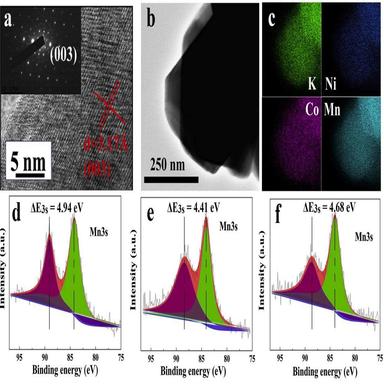
(a) HRTEM images and the corresponding SAED of the KNCMO sample (inset). (b–c) TEM images and corresponding EDS elemental mapping of K, Ni, Co and Mn elements of the KNCMO sample. (d–f) the Mn3s XPS spectra for KNCMO, Mg-doped, and Al-doped samples with their respective peak-splitting values.